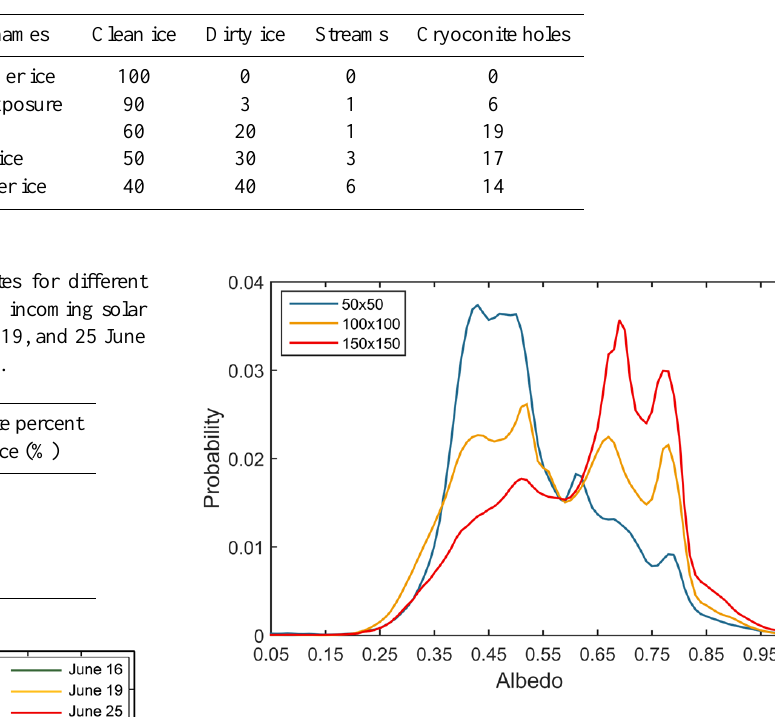
Figure 6. MOD10A1 2013 seasonal average albedo probability density distributions at three spatial extents: 50 × 50 MODIS pix- els (px), 100 × 100px, and 150 × 150px. The bimodal distribution seen at the 100 × 100px (46.3km 2 ) spatial extent is likely the result of almost equal area of snow and ice facies characterizing the two peaks. In contrast, the right and left skew distributions of 50 × 50px and 150 × 150px illustrate the dominance of ice and snow surfaces,